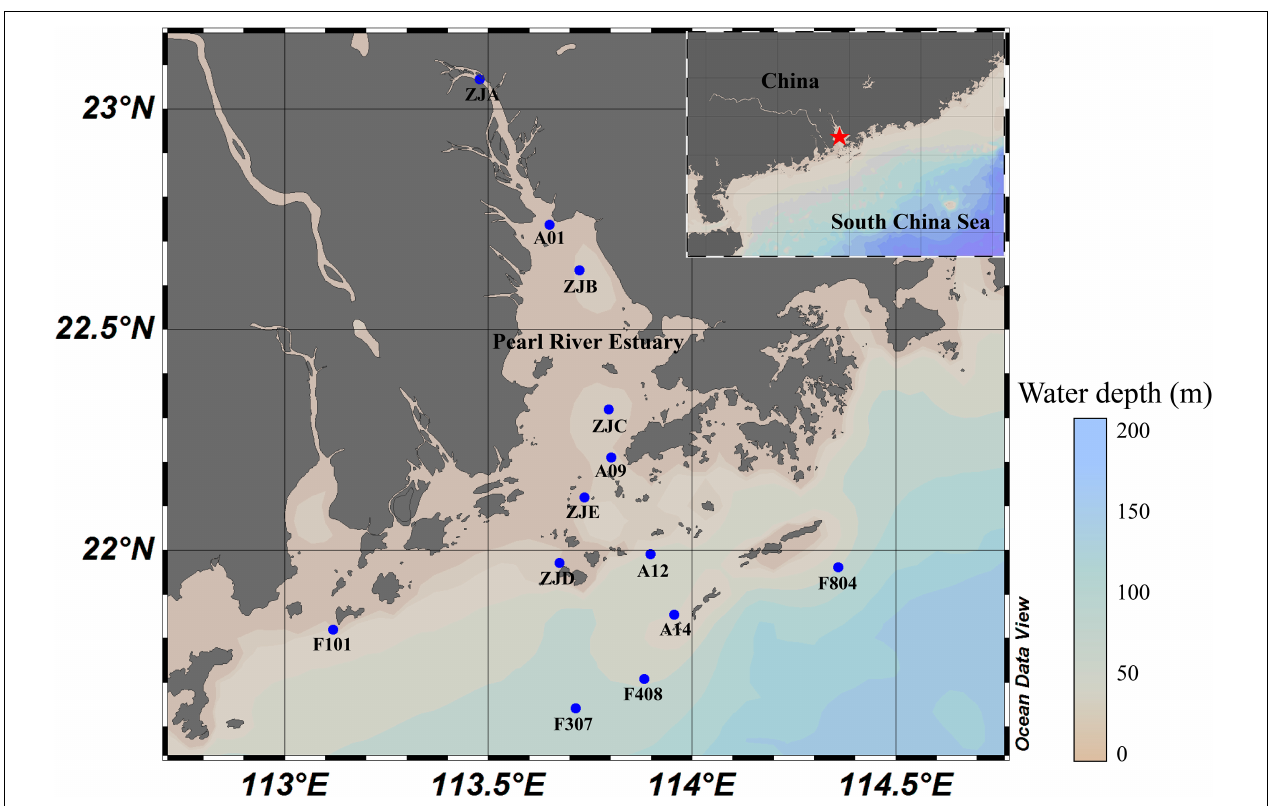
FIGURE 1 | Sampling stations in the PRE. Inset, overview of the studied area. Red star, the research area; blue dots, sampling